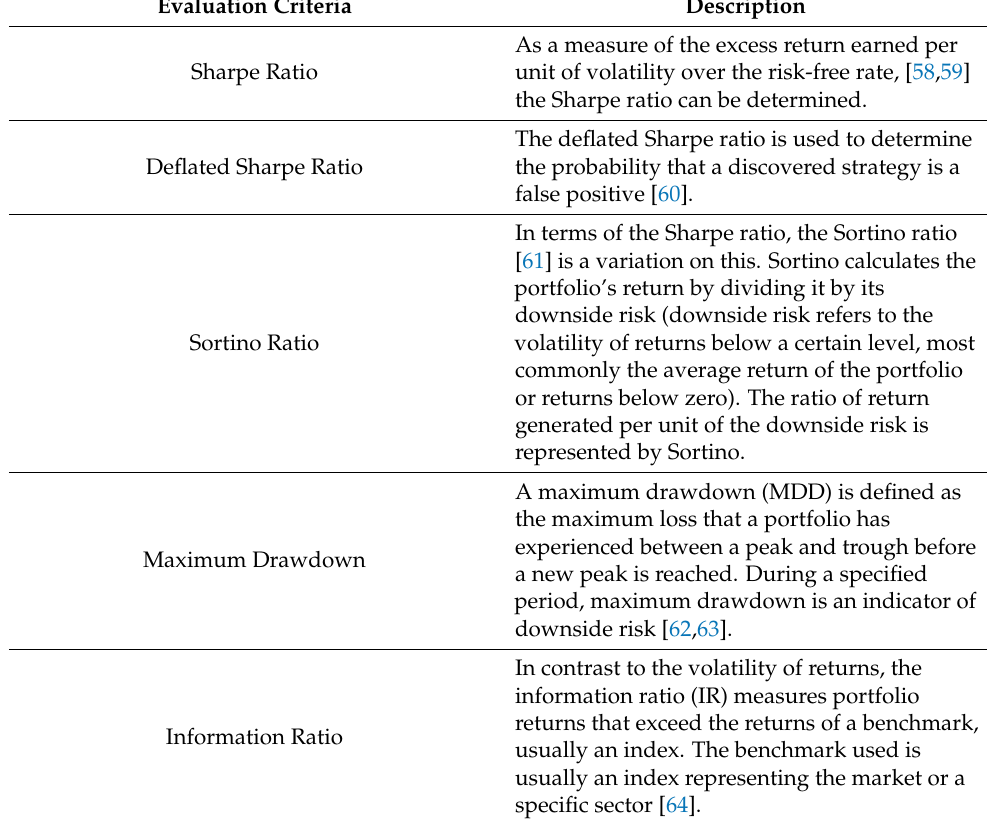
Table 6. Evaluation